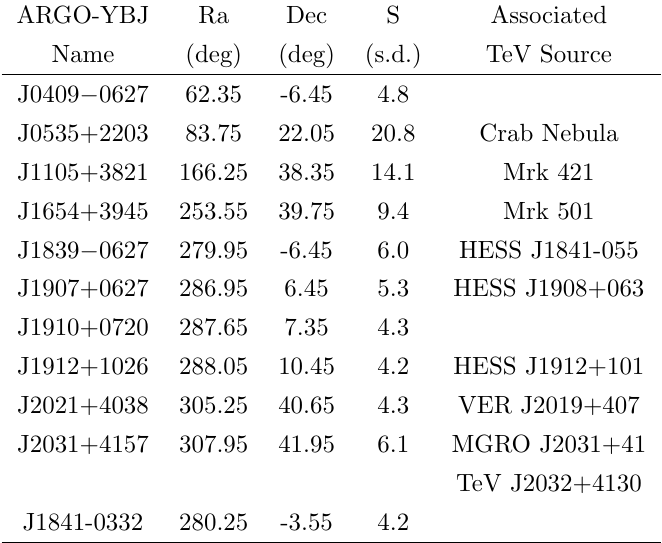
Table 1: Location of the excess regions